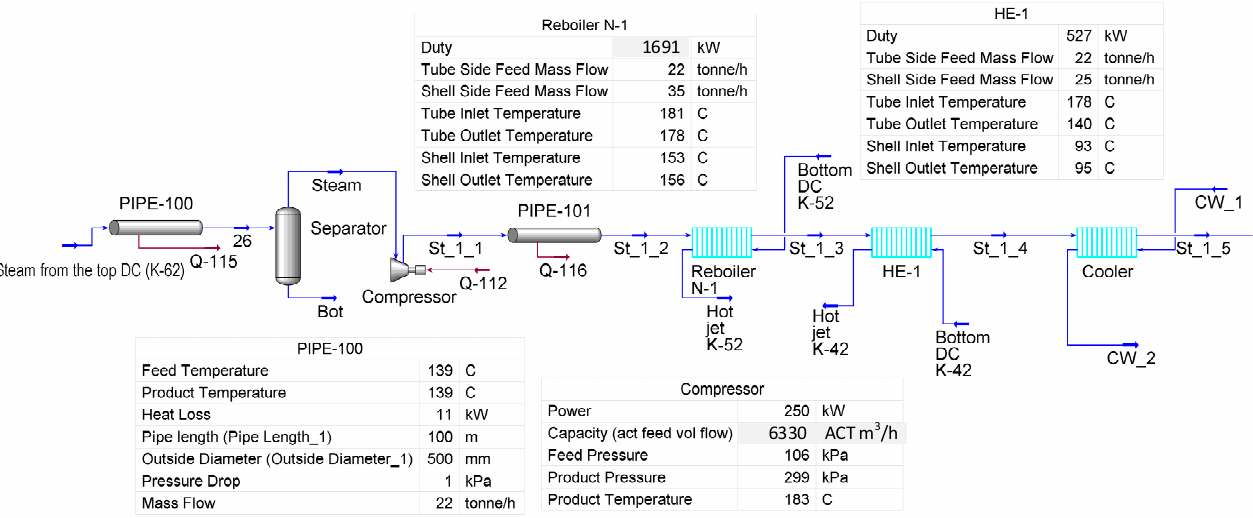
Figure 11. Hysys model step-by-step Pinch integration and HP integration between columns K-62 and K-52.